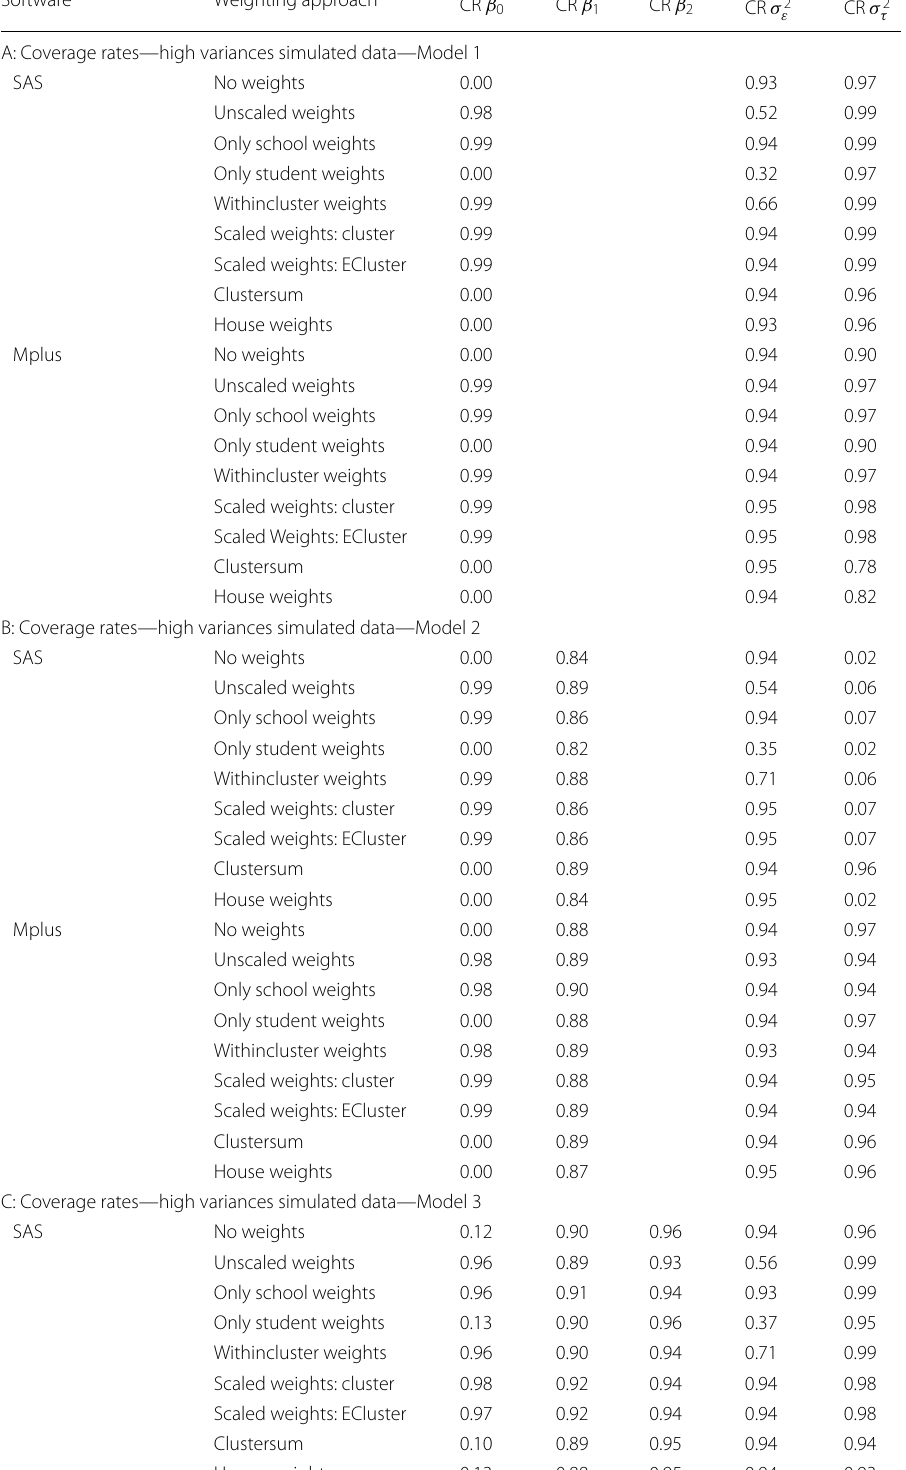
Table 7 Coverage rates of high variances simulated data